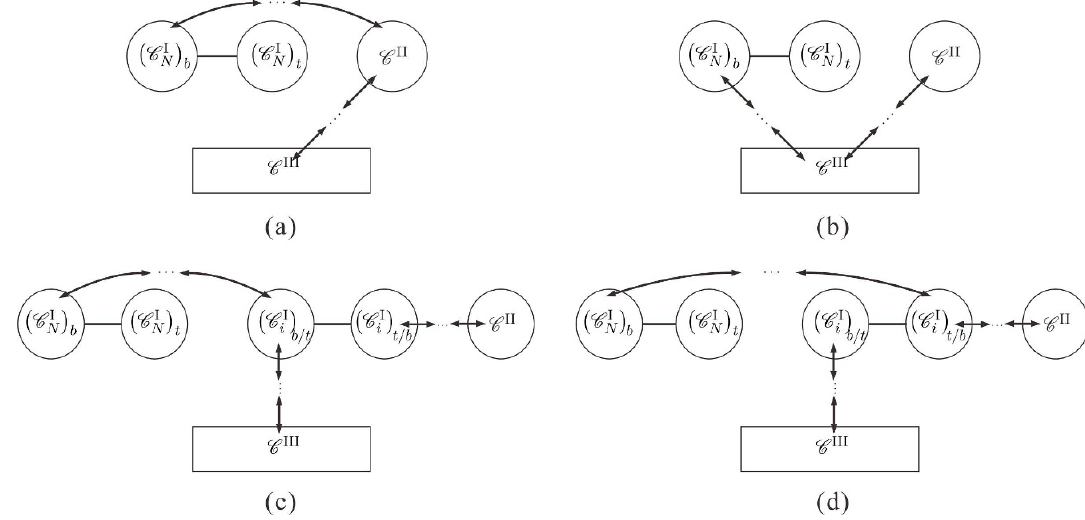
Figure 32 . According to the construction rule, the chain starts at the component C I must ends N at (i) the starting component (graph (a)), (ii) the ending component (graph (b)) or (iii) an internal component (graph (c) and (d)) of the chain led by C II . According to section 6.1, the chain led by (cid:2)(cid:0) C I (cid:1) (cid:0) C I (cid:1) (cid:3) C I in graphs (a)-(d) must be of the form (i) U 0 = (cid:0) ; : : : ; U = C II (graph (a)), N N N t b (cid:2)(cid:0) C I (cid:1) (cid:0) C I (cid:1) (cid:3) (cid:2)(cid:0) C I (cid:1) (cid:0) C I (cid:1) (ii) L 0 = (cid:0) ; : : : ; L = C III (graph (b)), (iii) U 0 = (cid:0) ; : : : ; U = C II N N N N t b t b (cid:2)(cid:0) C I (cid:1) (cid:0) C I (cid:1) (cid:0) C I (cid:1) (cid:0) C I (cid:1) (cid:3) (graph (c)) and (iv) L 0 = (cid:0) ; : : : ; (cid:0) ; : : : ; L = C III (graph i i N N t b t b